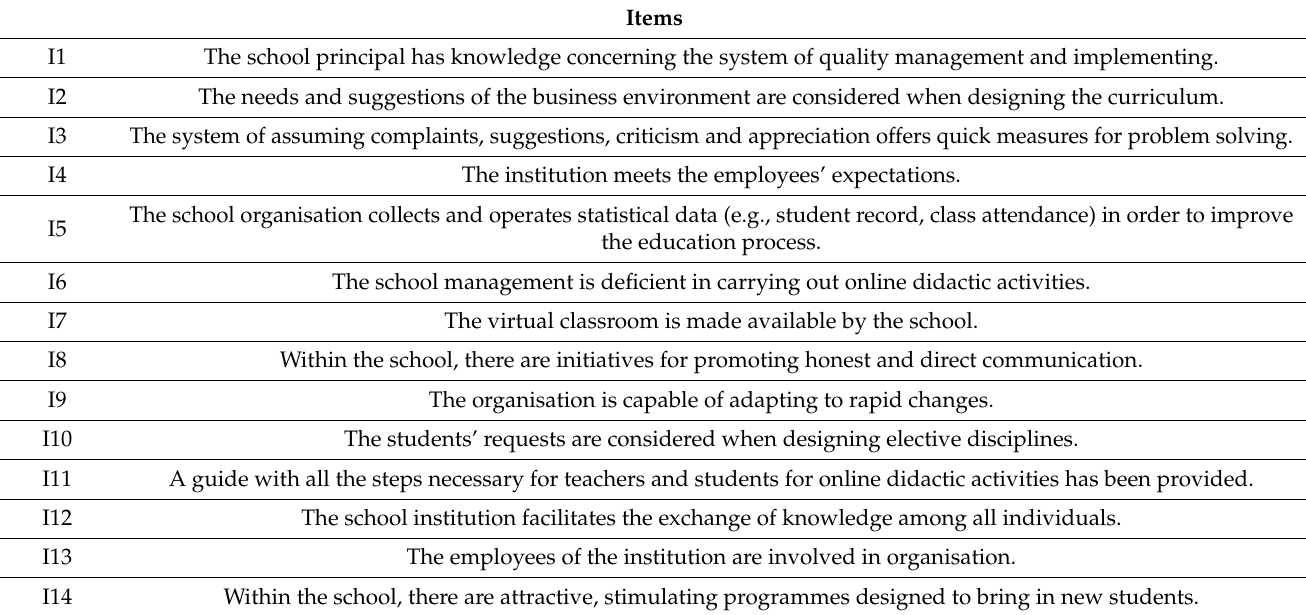
Table A1. Quality Management Education Scale (QMES) Items.